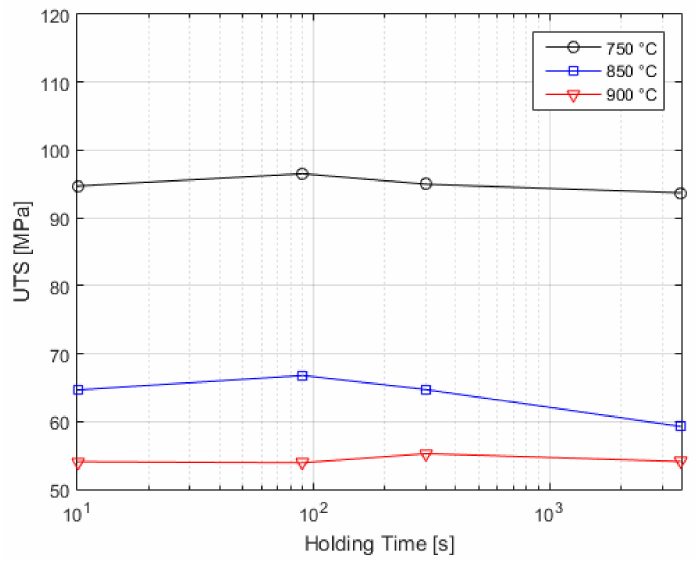
Figure 5. Ultimate tensile strength for different holding